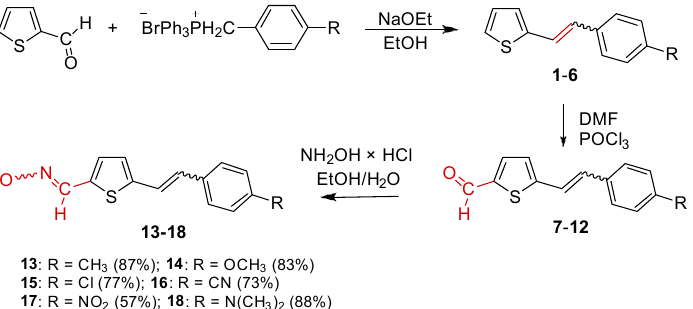
Scheme 1. The three-step reaction pathway for obtaining heterostilbene oxime derivatives 13 – 18 . The yields are expressed for the third reaction step.